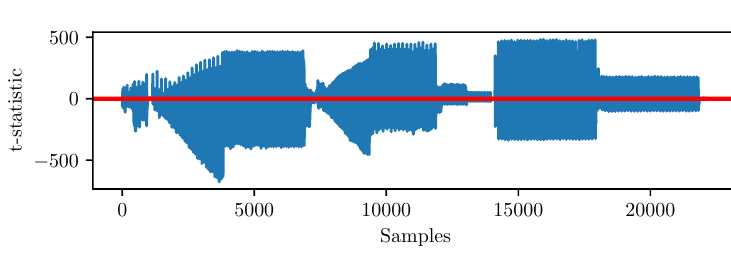
Figure 3: First-order t -test results of the first-order implementation with masks disabled and 10 000 measurements. The red lines indicate the threshold of ± 4 . 5.